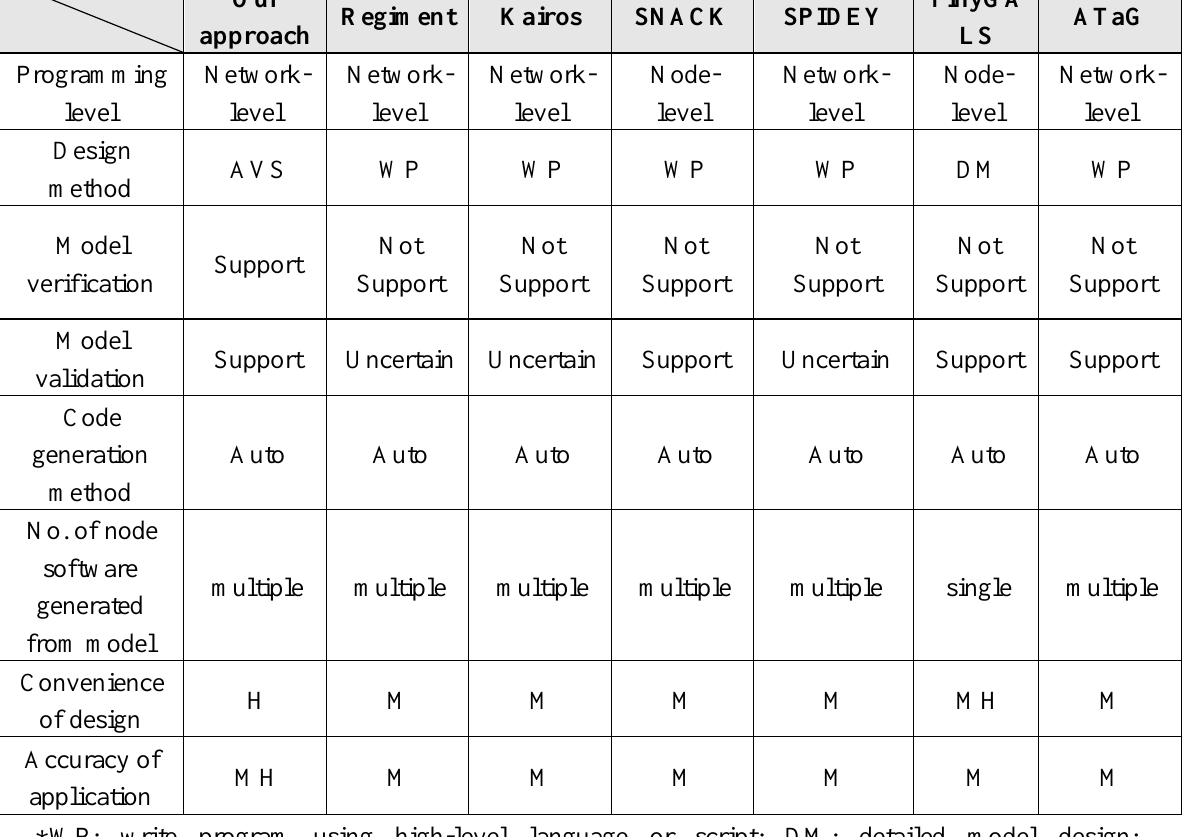
Table 7 . Comparison of the techniques for USN application